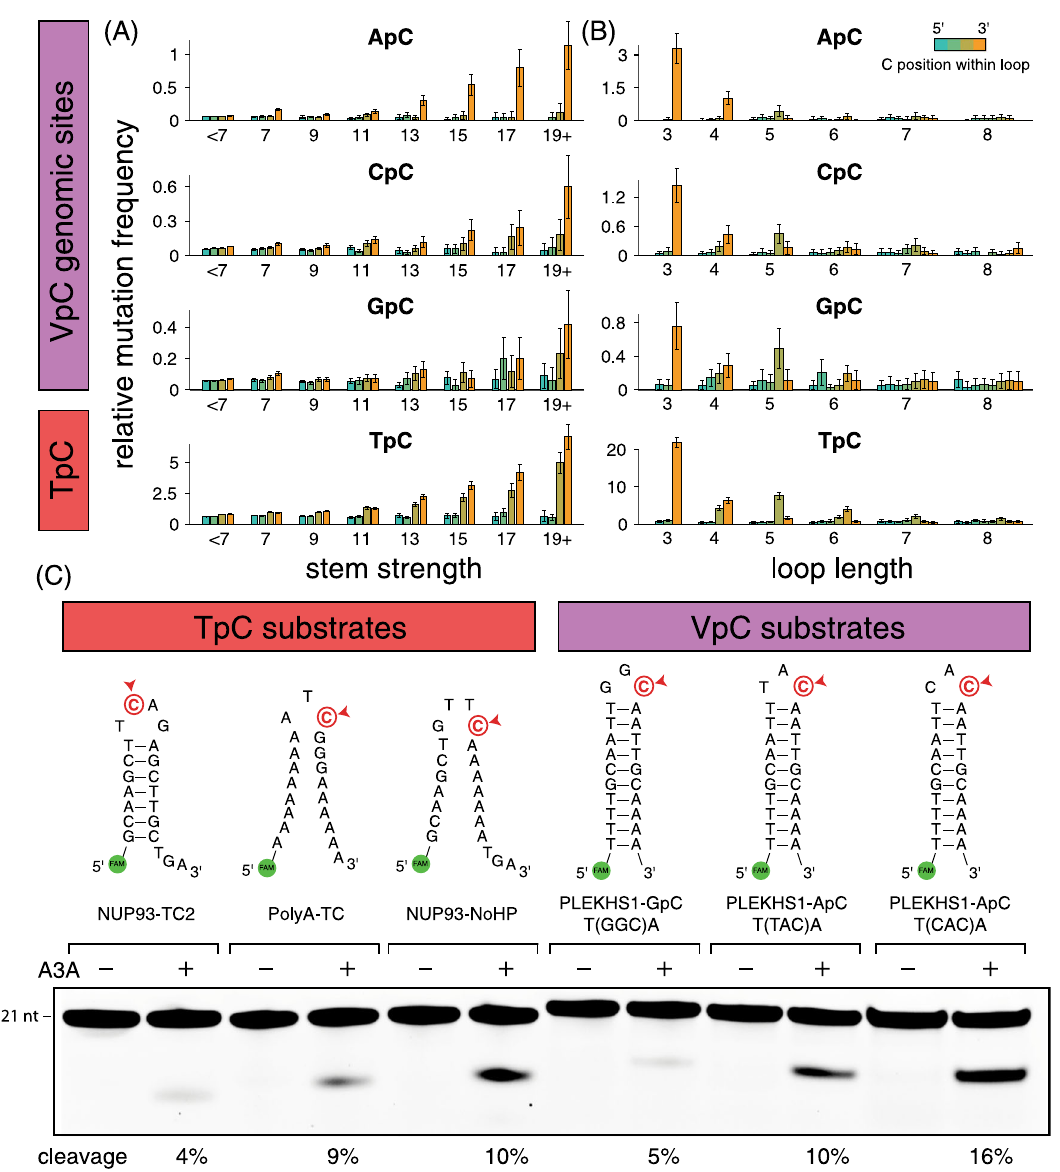
Fig. 2 VpC sites and TpC sites show similar patterns of mutability. A Relative mutation frequency in APOBEC + tumor samples increases with strength of hairpin base-pairing potential, both for TpC genomic sites, as well as for ApC, CpC, and GpC genomic sites (collectively known as VpC sites). Error bars represent 95% con fi dence intervals. B Mutation frequency decreases with size of hairpin loop, and requires optimal positioning of the cytosine within the loop, both for TpC and VpC sites. Error bars represent 95% con fi dence intervals. C In vitro APOBEC3A activity assay shows that APOBEC3A substrate optimality is jointly determined by sequence and structure, both for TpC and VpC sites. Source data are provided as a Source Data fi